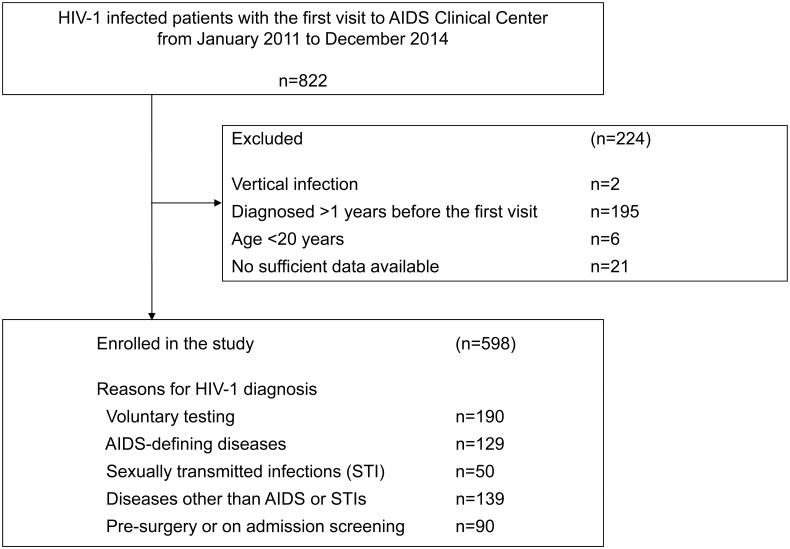
Patient enrollment process.